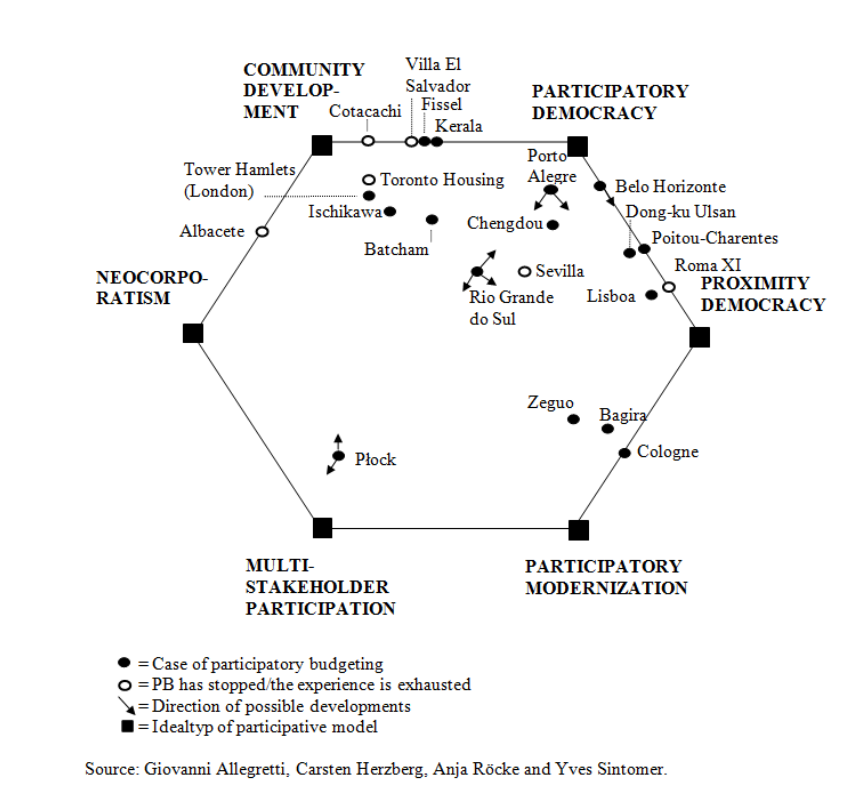
Figure 3: Typology of models of participation in the World (with the example of participatory